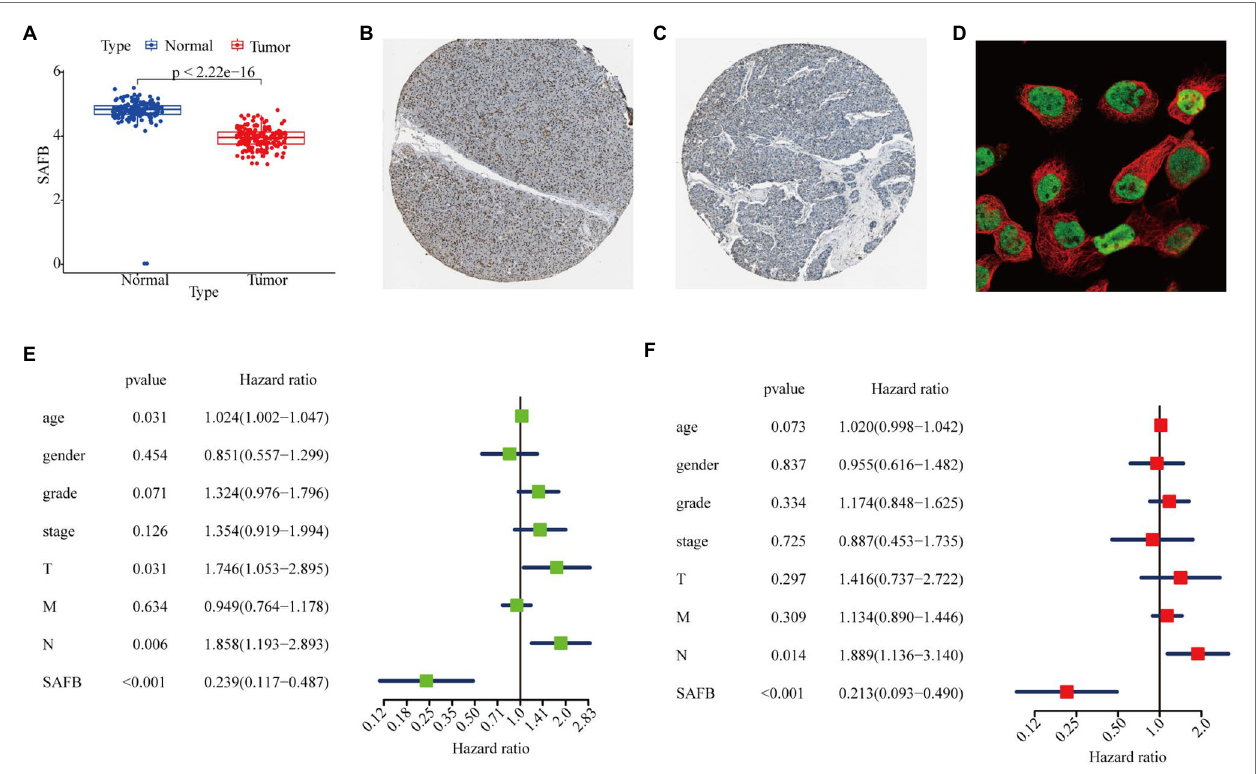
FIGURE 4 | Expression profile and independent prognostic analyses of scaffold attachment factor B (SAFB) in PAAD. (A) Differential expression analysis of SAFB between PAAD and normal pancreatic tissues based on The Cancer Genome Atlas (TCGA) and Genotype-Tissue Expression (GTEx) databases. Immunohistochemistry analysis of SAFB based on the Human Protein Atlas (HPA) database. (B) Protein levels of SAFB in the normal pancreatic tissue (staining: high; intensity: strong; quantity: >75%). (C) Protein levels of SAFB in the PAAD tissue (staining: low; intensity: moderate; quantity: <25%). (D) Cellular location of SAFB expression. (E) Univariate Cox regression analysis of the association among SAFB expression, clinicopathological parameters, and the OS of patients in the TCGA cohort. (F) Multivariate Cox regression analysis of the association among SAFB expression, clinicopathological parameters, and the OS of patients in the TCGA